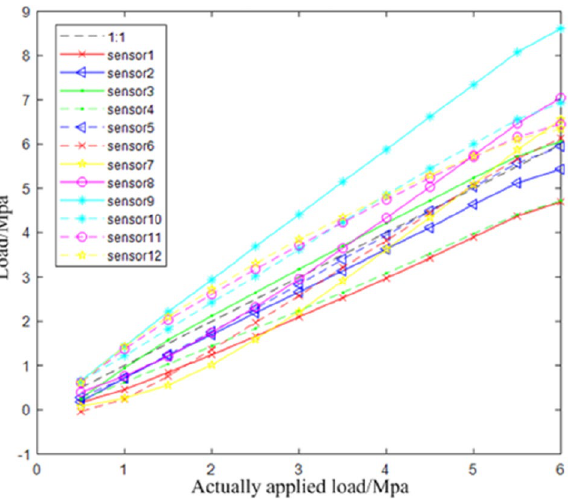
Figure 18. Relationship curve between applied load and detected load of bias pressure.